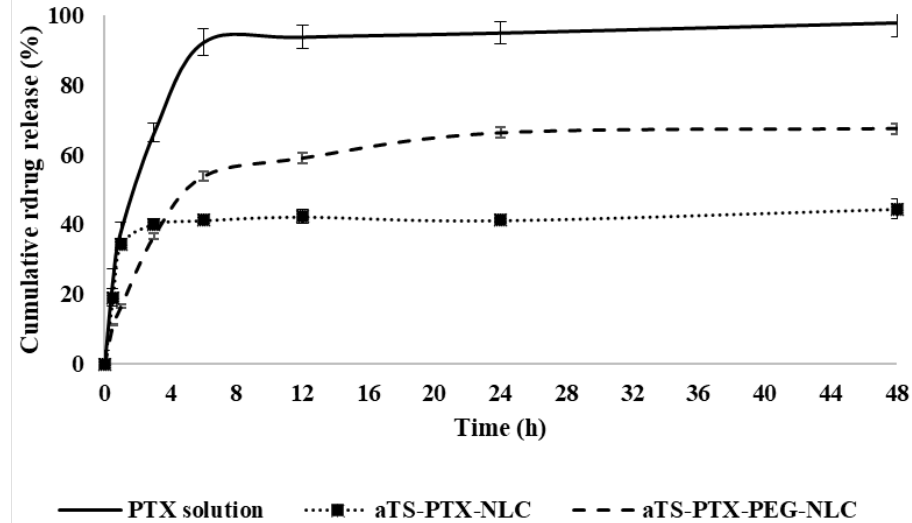
Figure 6. Release of PTX from α TS-PTX-NLC, α TS-PTX-PEG-NLC and control solution.